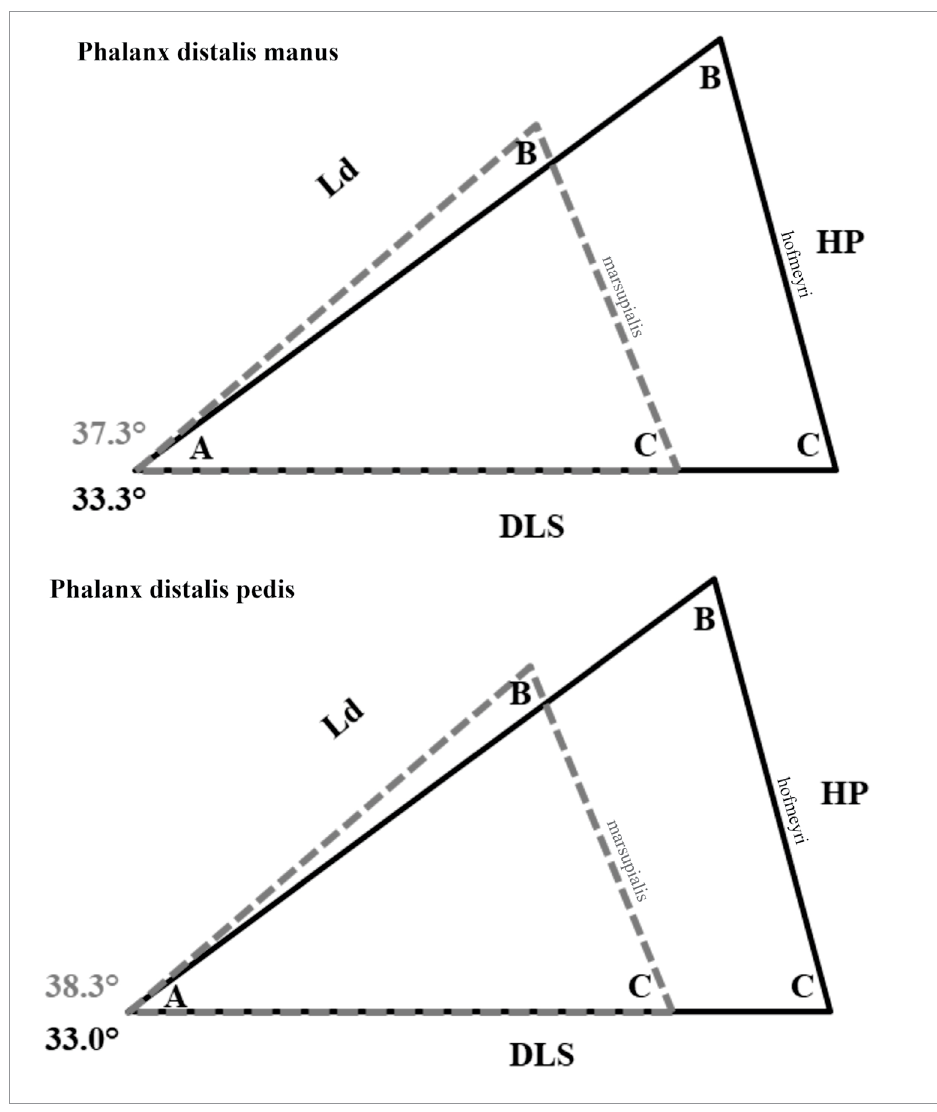
Ld, length of dorsal surface; HP, height in the region of the extensor process; DLS, (greatest) diagonal length of sole Figure 4: Diagrammatic representation of distal phalanges manus (A) and pedis (B) in both subspecies. Trigonometric formulae for solution of oblique triangles were based on means for DLS, Ld and HP and calculated for dorsal to palmar / plantar surface (AB to AC), dorsal to proximal surface (AB to BC) and the proximal to palmar / plantar surface (BC to